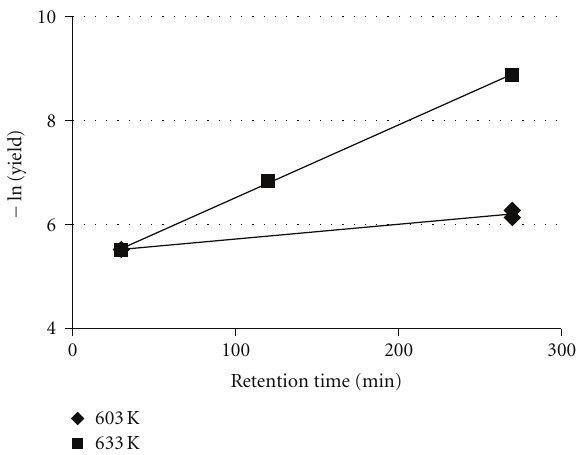
Figure 7: Guaiacol yield after hydrothermal treatment of lignin with RANEY Nickel.